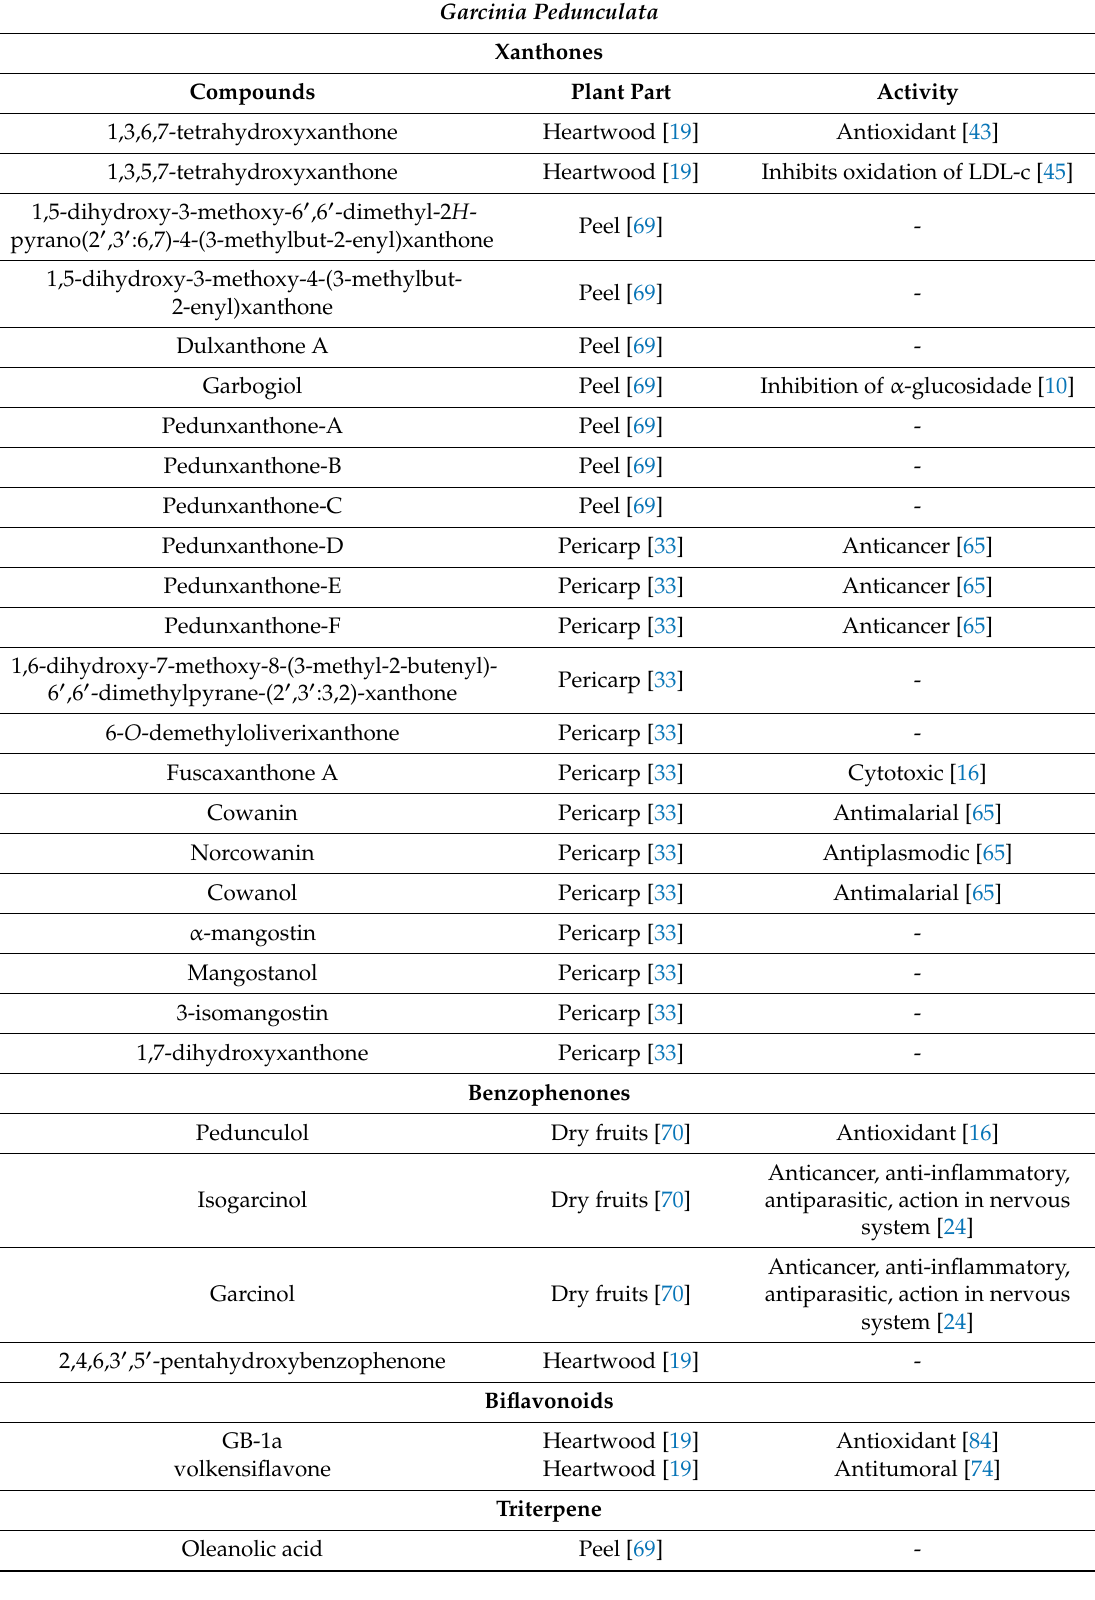
Table 3. List of compounds present in di ff erent parts of Garcinia pedunculata and related